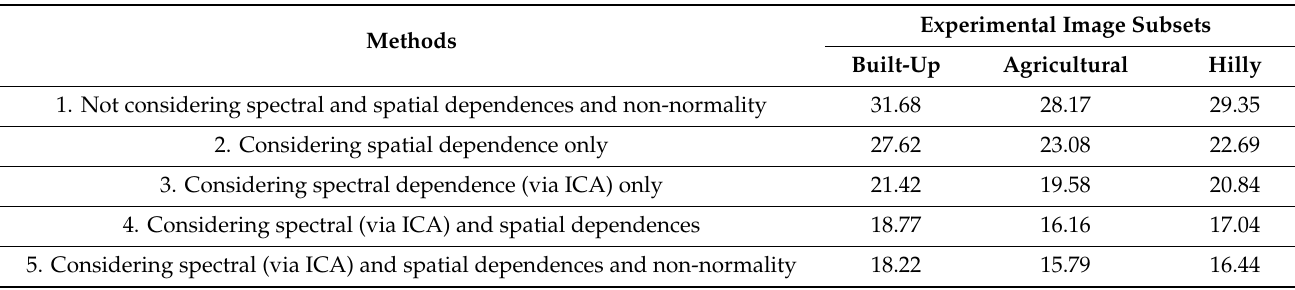
Table 6. Estimates of information content for the three image subsets using di ff erent methods (bits /